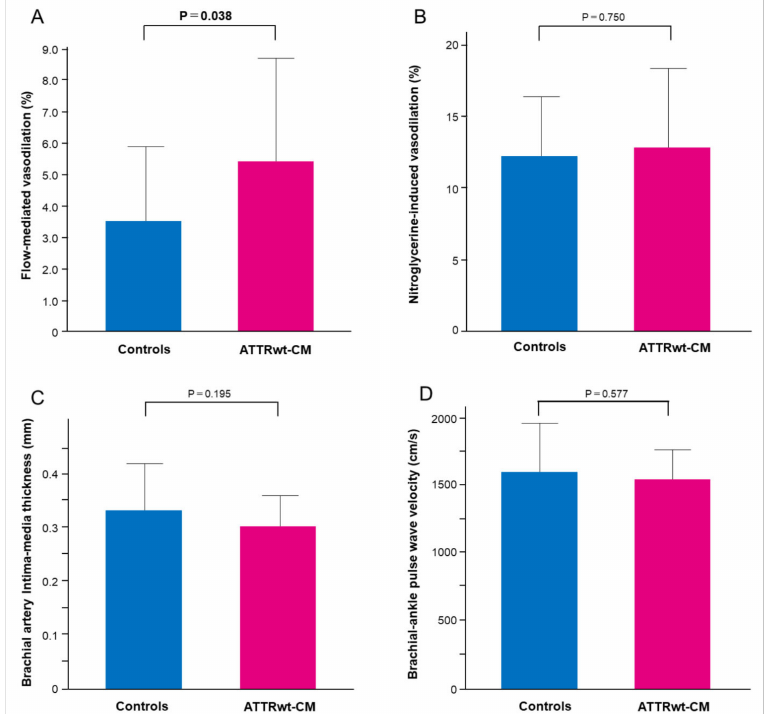
Figure 1. Comparison of flow-mediated vasodilation (FMD), nitroglycerine-induced vasodilation (NID), brachial intima-media thickness (bIMT) and brachial-ankle pulse wave velocity (baPWV) between controls and wild-type transthyretin amyloid cardiomyopathy (ATTRwt-CM). Bar graphs show FMD ( A ) and NID ( B ), bIMT ( C ) and baPWV ( D ) in controls and patients with